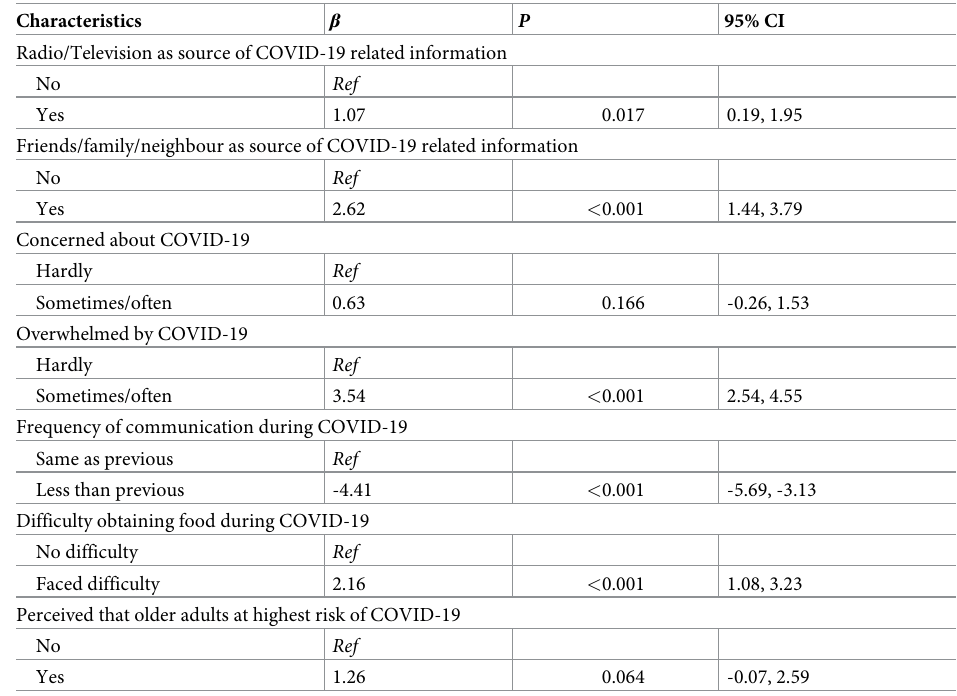
Table 3. Factors associated with fear among the participants (N =